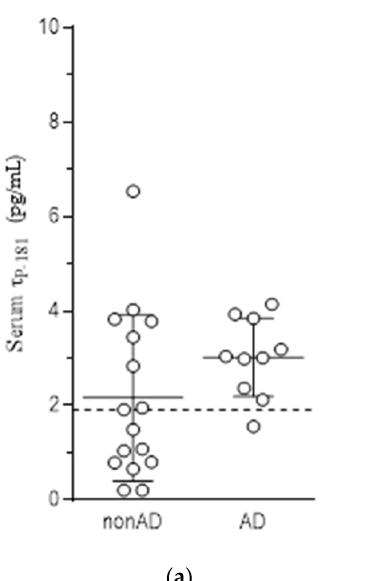
Table 4. Receiver Operating Characteristics (ROC) analysis of the discriminant value for each of the studied biomarkers.